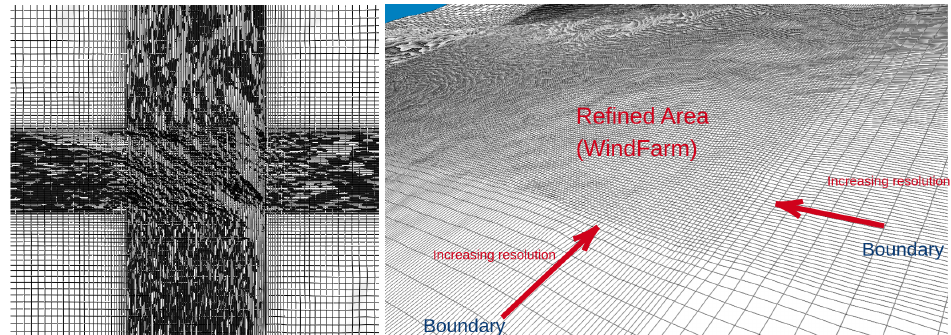
Figure 4. Grid resolution in the horizontal plane: from the boundary to the investigated area (WindFarm), the spacing is refined from 270 to 17